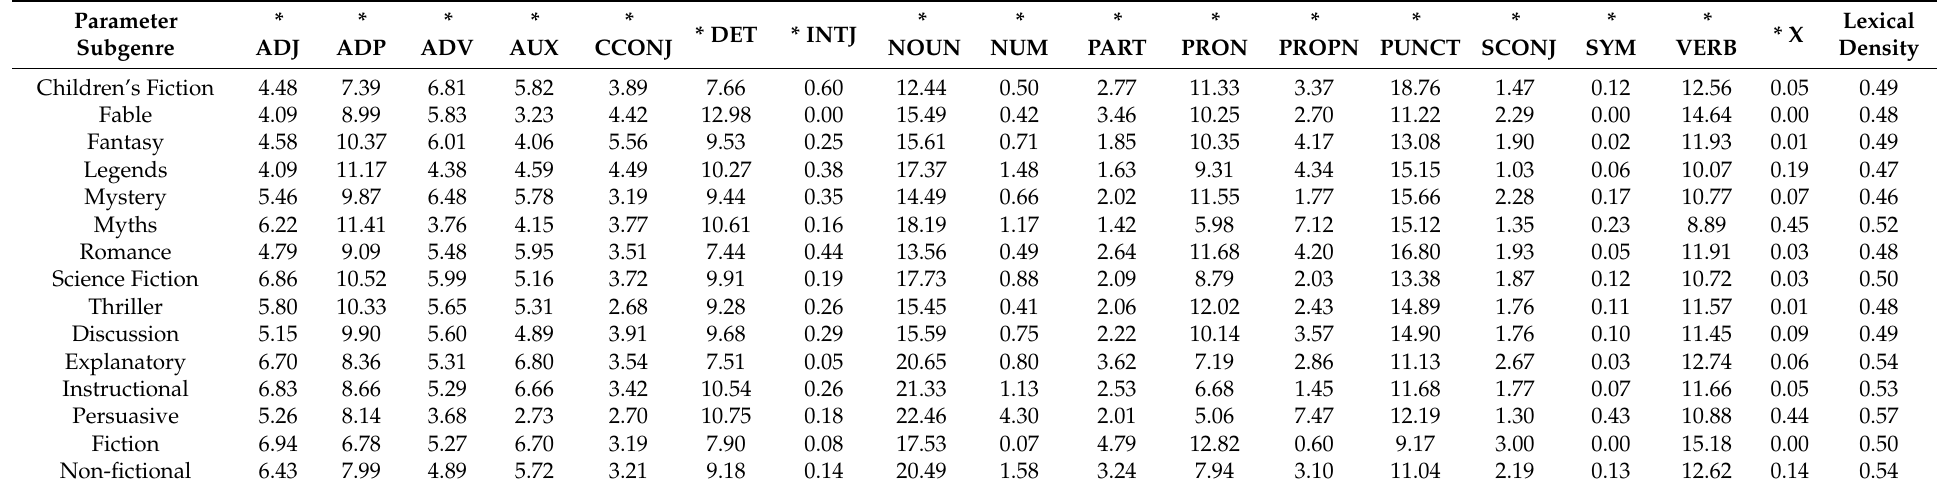
Table 5. Summary of parts of speech across and lexical density of various